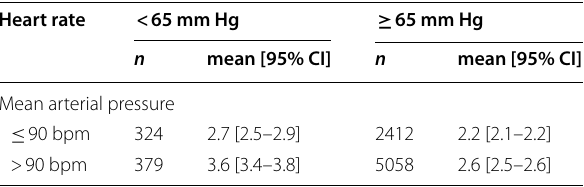
Table 2 Adjusted model-estimated serum lactate